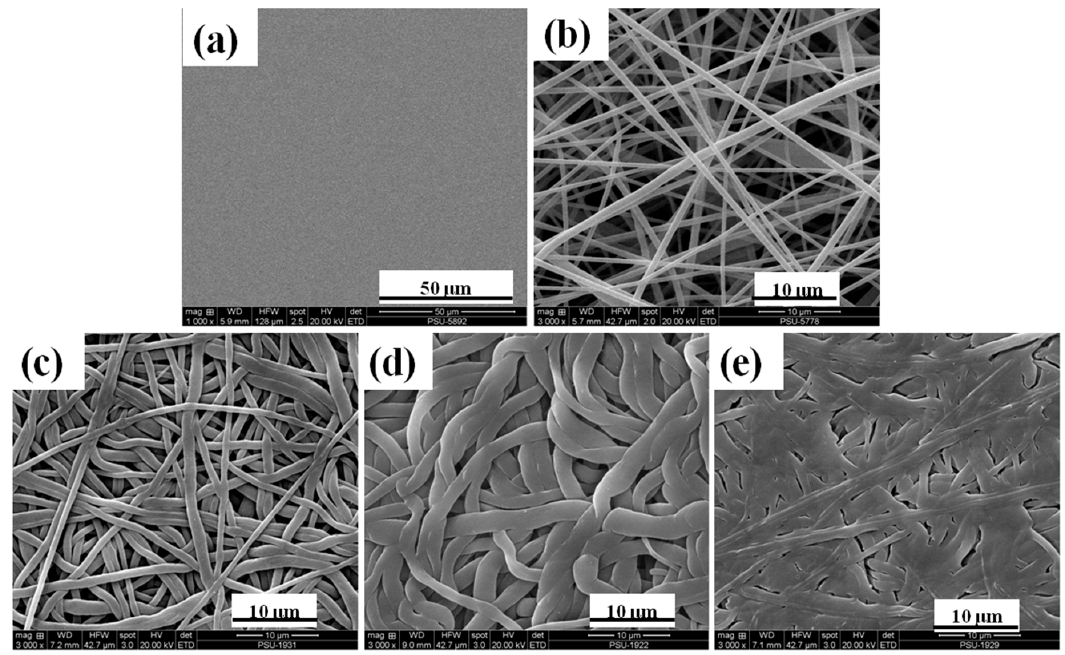
Figure 3. SEM images of the P(VDF-HFP) ( a ) film, ( b ) fiber, ( c ) 30 °C compressed fibers, ( d ) 60 °C compressed fibers, and ( e ) 80 °C compressed fibers .